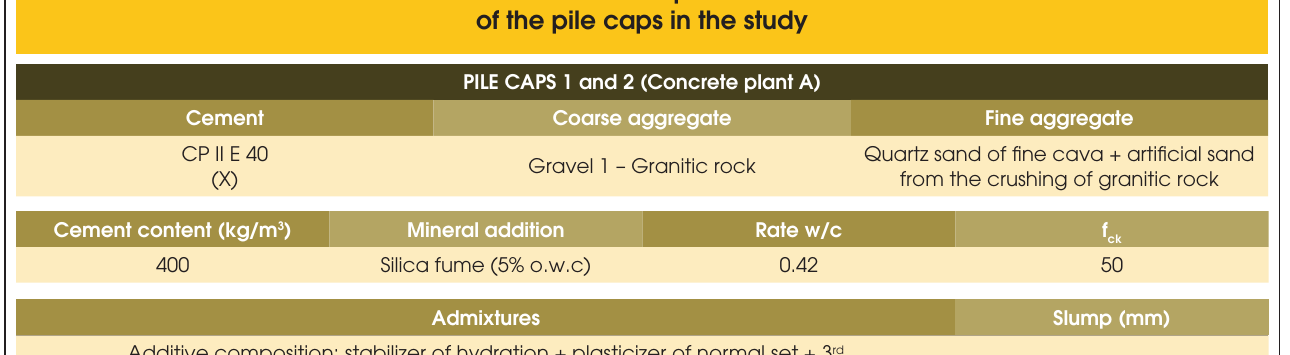
of the pile caps in the